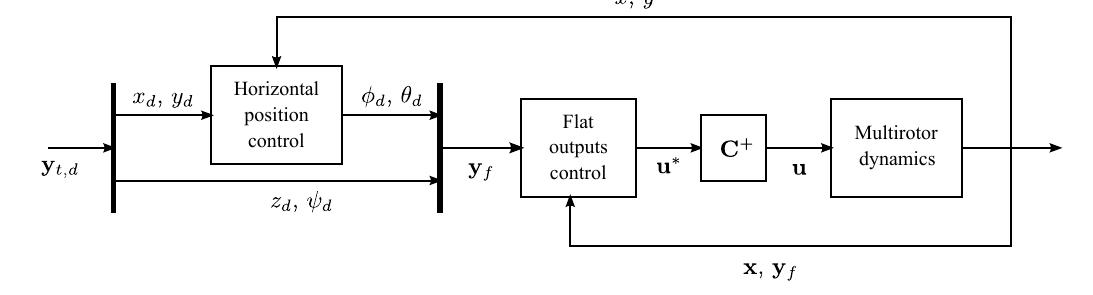
Figure 5. Structure of under-actuated multirotor